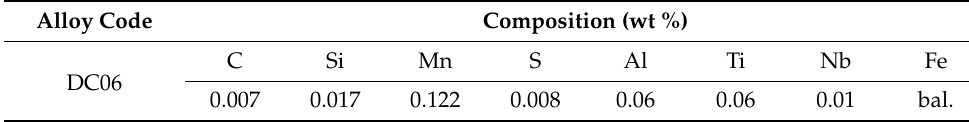
Table 1. Chemical compositions of the investigated DC06 steel. Alloy